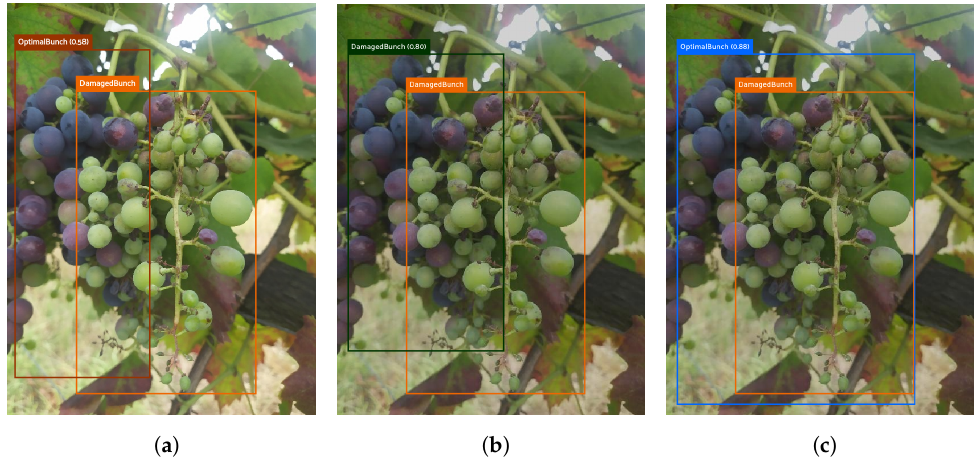
Figure 10. FPs in samples in the test set. Orange bounding boxes present ground truth. Red bounding boxes present the predictions from YOLOv5. Green bounding boxes present the predictions from YOLOv7. Blue bounding boxes present the predictions from YOLOR. ( a ) YOLOv5. ( b ) YOLOv7. ( c )